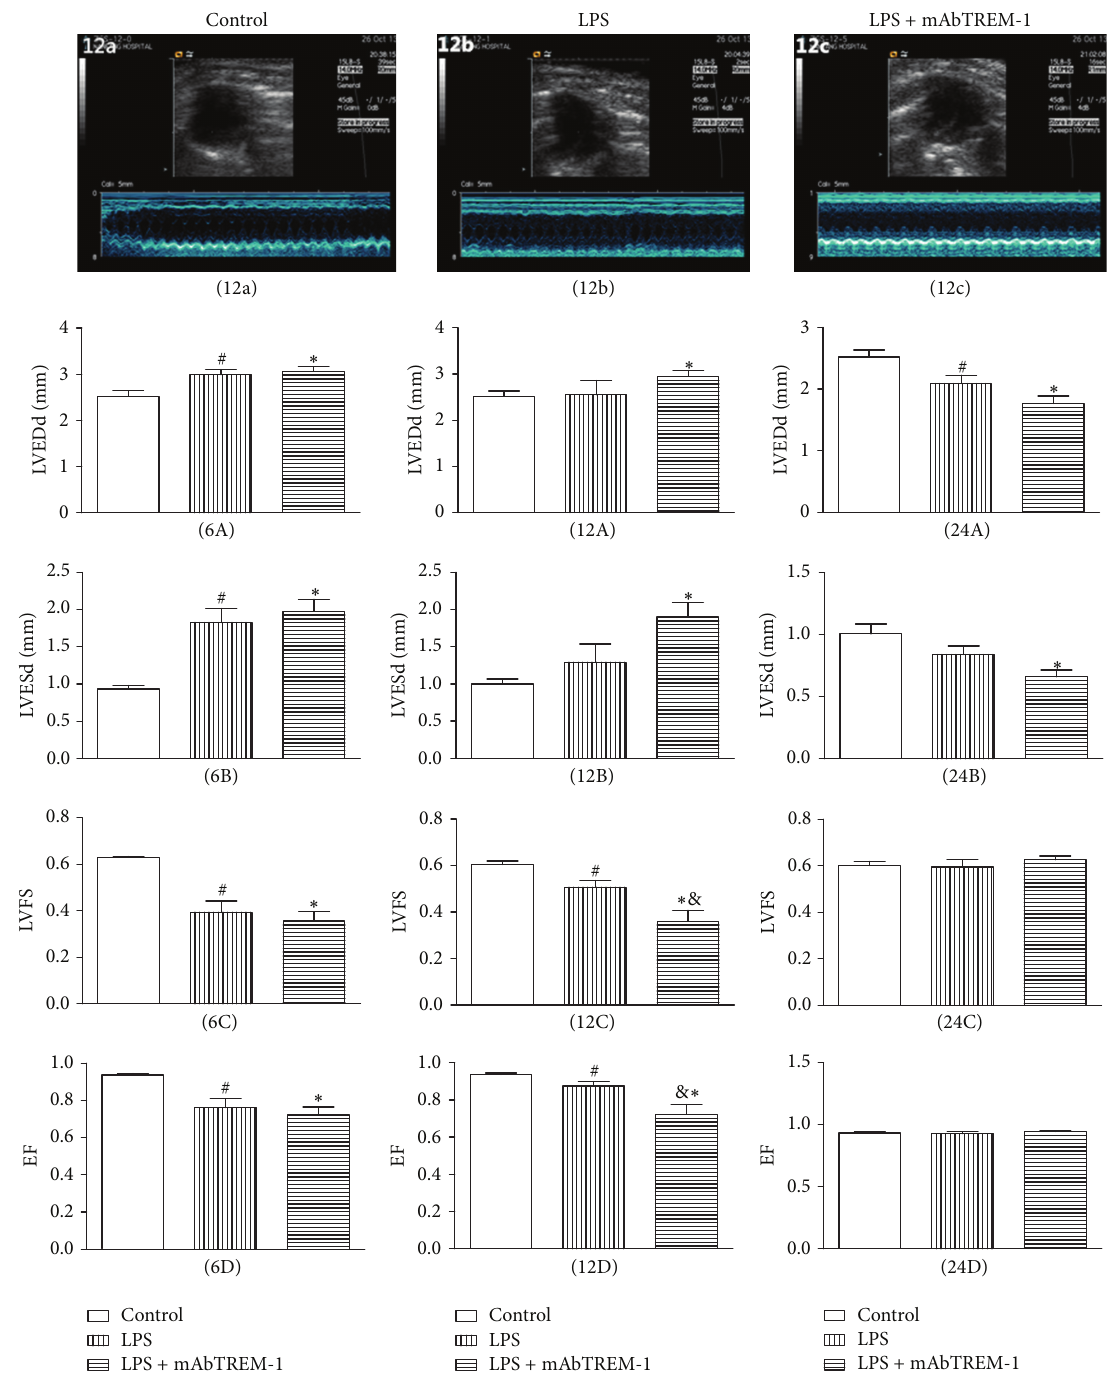
Figure 1: mAbTREM-1 deteriorates left ventricular systolic function in mice following LPS treatment. (12a), (12b), and (12c) represent M- mode echocardiograms among 3 groups at 12h, respectively. Bar graphs demonstrating differences in echocardiographic left ventricular parameters(LVEDd,LVESd,FS,EF)at6h((6A)–(6D)),12h((12A)–(12D)),and24h((24A)–(24D))among3groupsasdescribedinMaterials and Methods; LVESd: left ventricular end-systolic diameter, LVEDd: left ventricular end-diastolic diameter, FS: fractional shortening (%), and EF: ejection fraction (%); data are expressed as MEAN ± SEM; # 𝑃 < 0.05 compared with saline-treated mice, ∗ 𝑃 < 0.05 compared with saline-treated mice, and & 𝑃 < 0.05 compared with LPS-treated